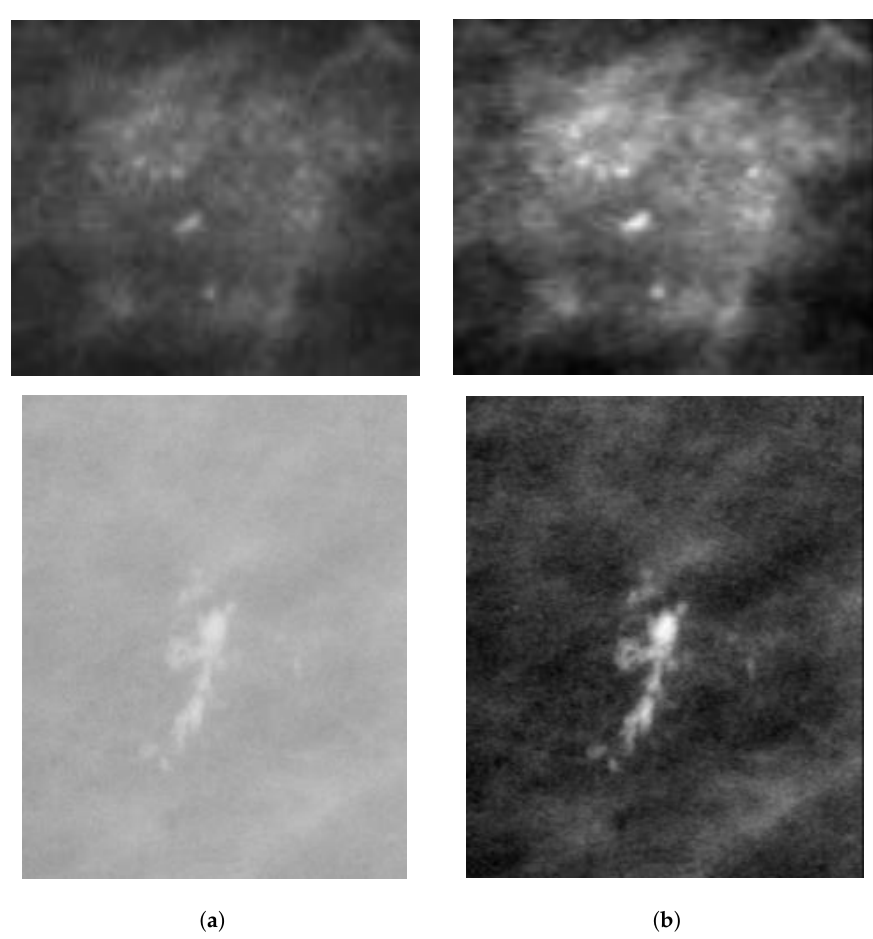
Figure 3. Example enhancement of MC clusters: digital mammogram from the OMI-DB database (top row: 1_1076_463) and digitized mammogram from the DDSM database (bottom row: B_3049_1.RIGHT_MLO): ( a ) MC patch cropped from the original mammogram (without image enhancement); and ( b ) MC patch cropped after